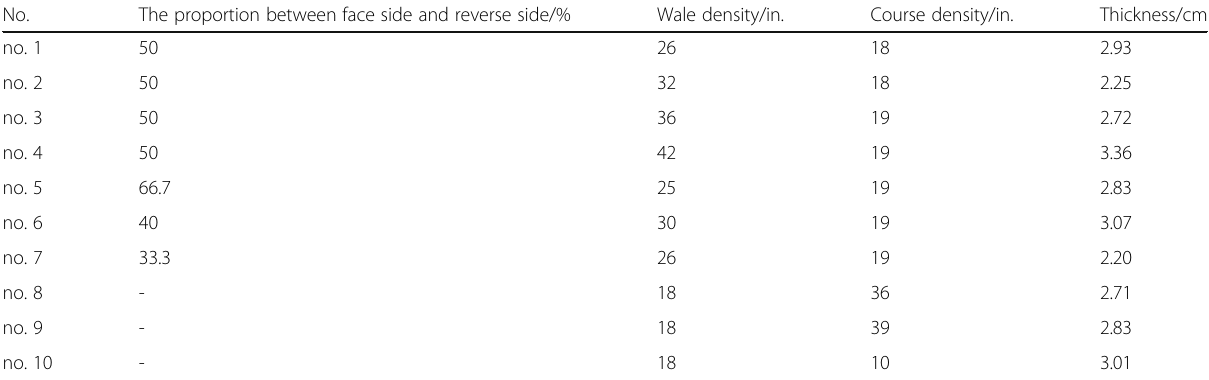
Table 2 Parameters of knitted textiles No. The proportion between face side and reverse side/% Wale density/in. Course